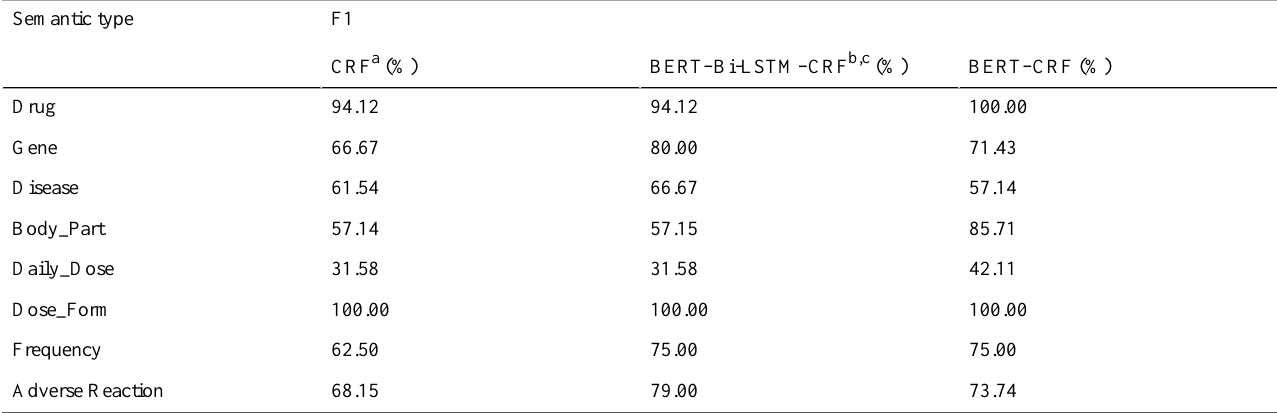
Table 4. Performance of the semantic type.